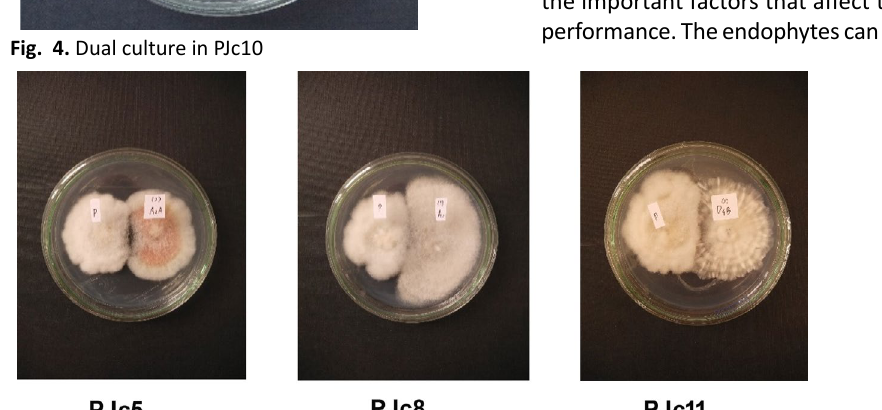
Fig. 4. Dual culture in PJc10